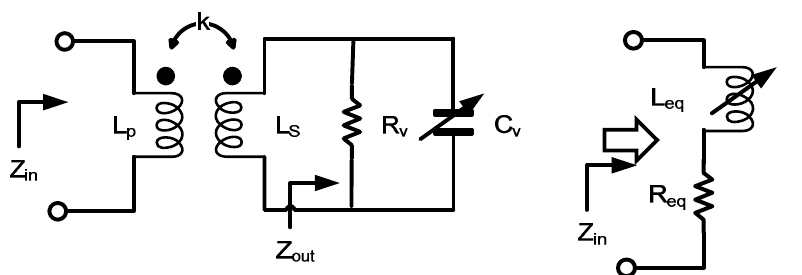
Figure 1. Configuration of a conventional loaded transformer ‐ based variable inductor.